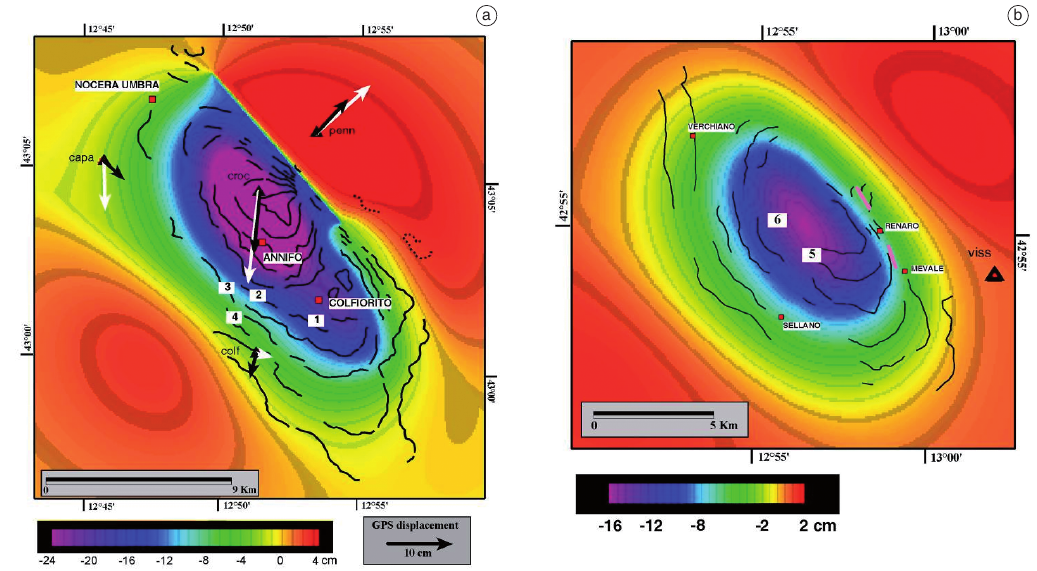
Fig. 2a,b. The distribution of GPS stations and the GPS and SAR modelling from the IGM 95 benchmarks dur- ing the 1997 Umbria-Marche earthquakes for the epicentres of September 26, 1997 Colfiorito a) and b) the epi- centre of October 14, 1997, Sellano earthquake. The lack of the GPS benchmarks around the epicentre at Sel- lano is evident and the fortunate positions of the GPS benchmarks across the fault between Colle Croce and Monte Pennino (from Salvi et al. ,